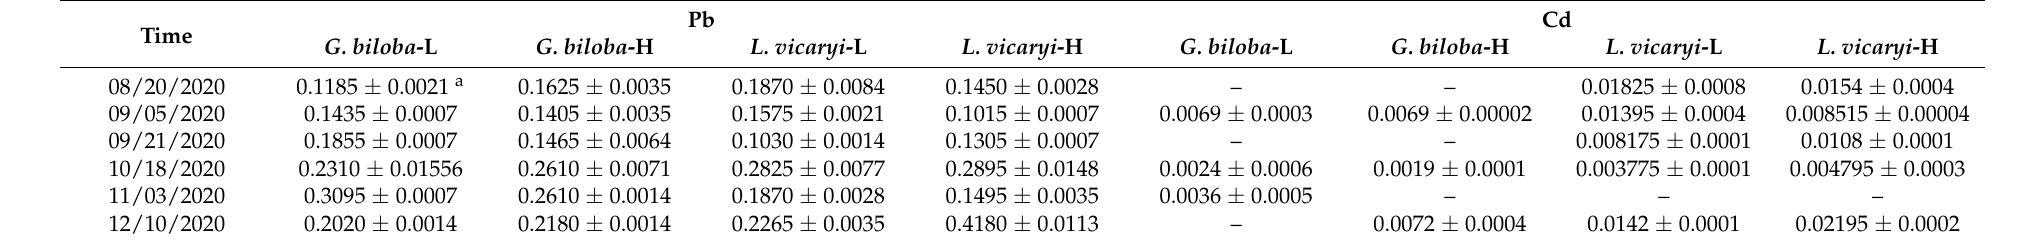
Table 4. Heavy metal level in plants based on single factor index